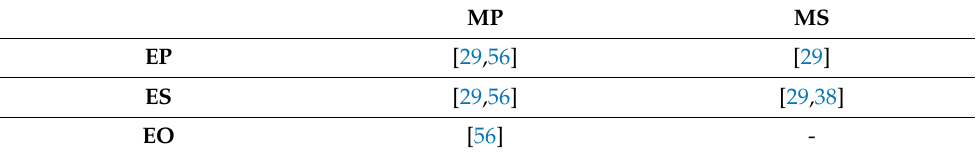
Table 6. References described in Section 2.3, ordered by the two compounds of the mixture 1